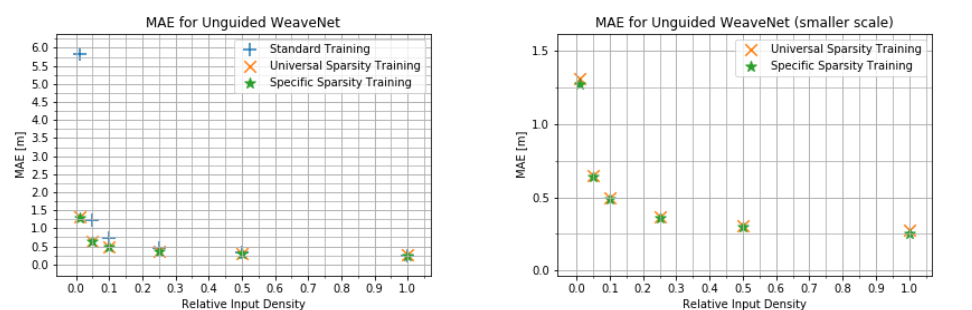
Figure 4. MAE for the unguided WeaveNet for various input densities for different training modes (different scales).